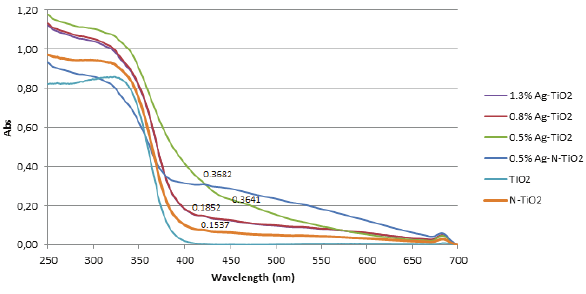
NPs and Ag-N- 2 2